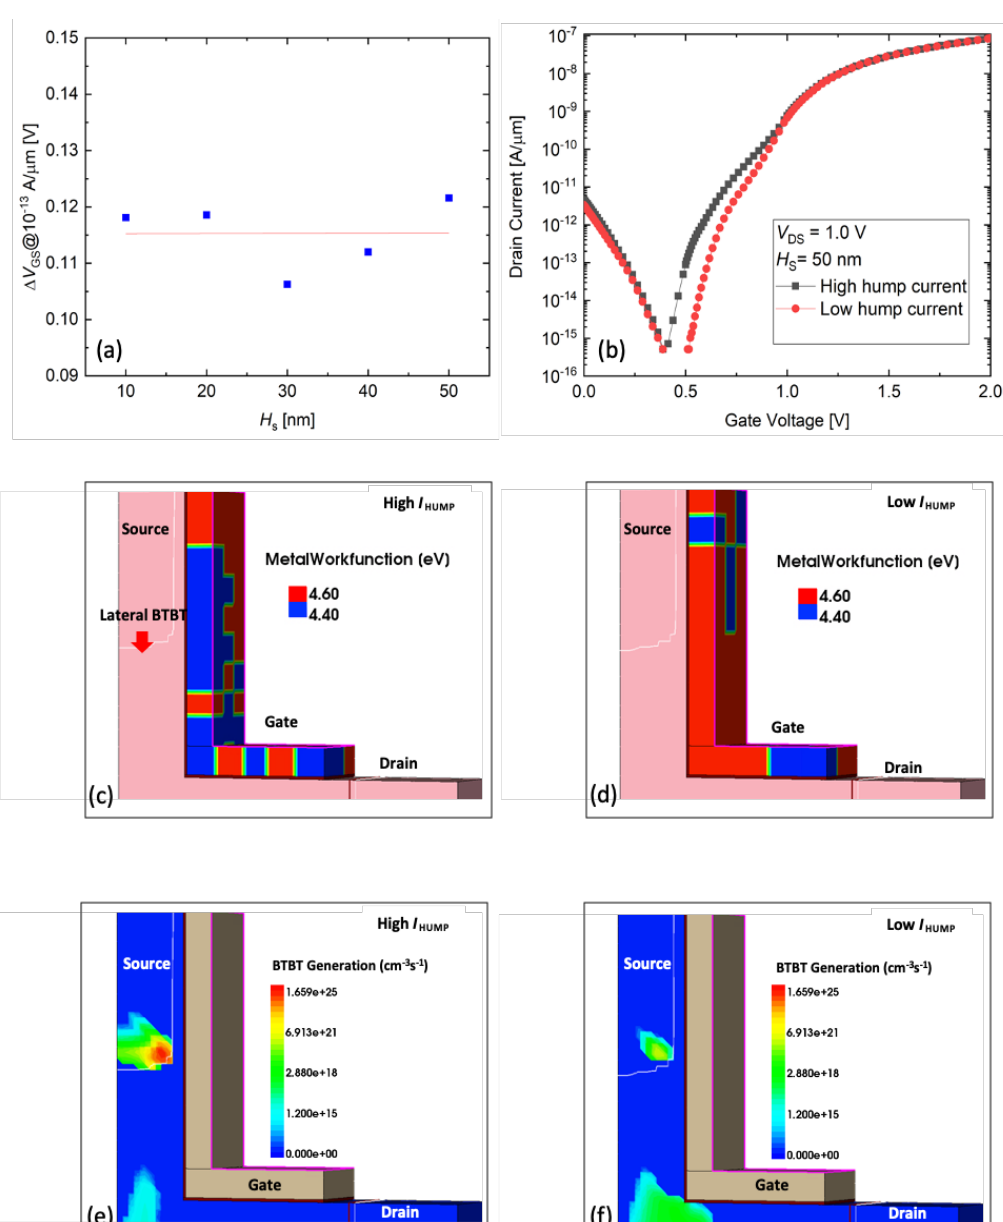
Figure 4. ( a ) I HUMP variation dependency on H S . ( b ) Transfer characteristics with high and low I HUMP . TiN-grains distribution in gate area for ( c ) high I HUMP sample and ( d ) low I HUMP sample. BTBT rate for ( e ) high I HUMP sample and ( f ) low I HUMP sample.